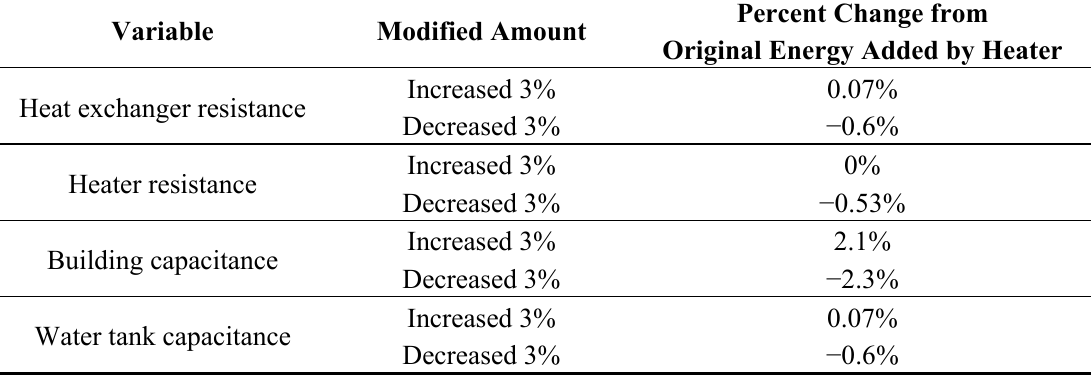
Table 4. Sensitivity analysis